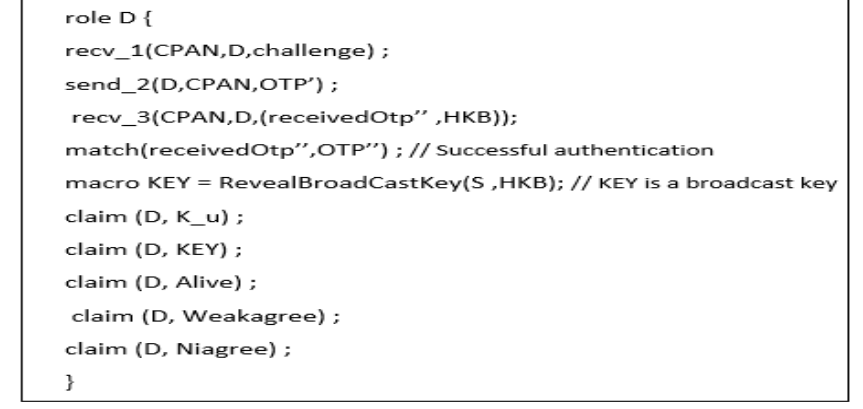
Figure 4. Role of device